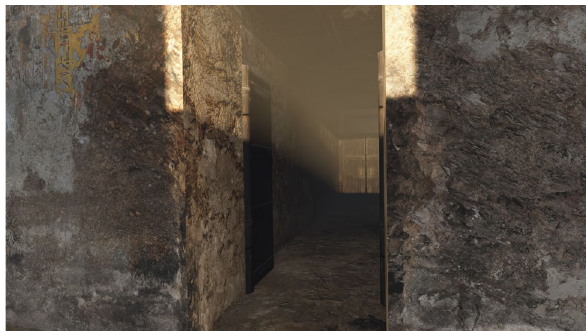
Figure 14 . View from the transverse room towards the longitudinal room. Step 2 with the second door open and the entrance door